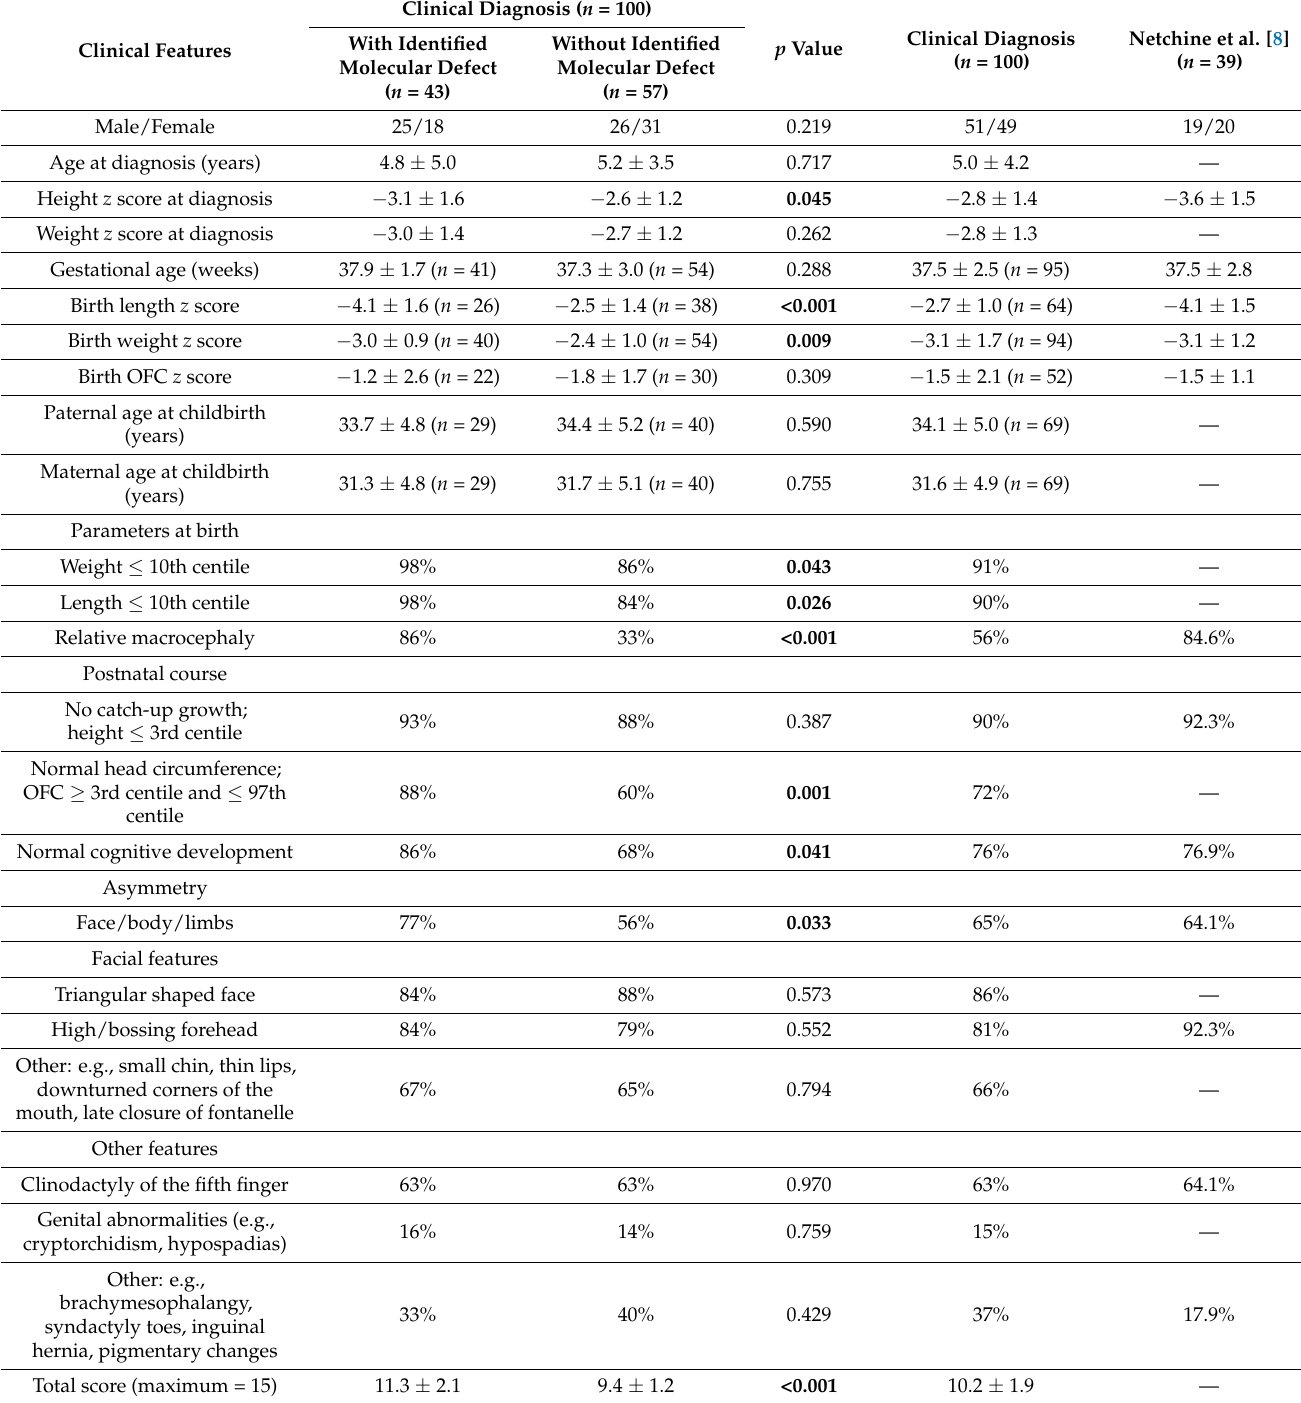
Table 3. Clinical features of 100 subjects with a clinical diagnosis of SRS with and without molecular defects in the present study compared with those in the report of Netchine et al. [8] ( n =